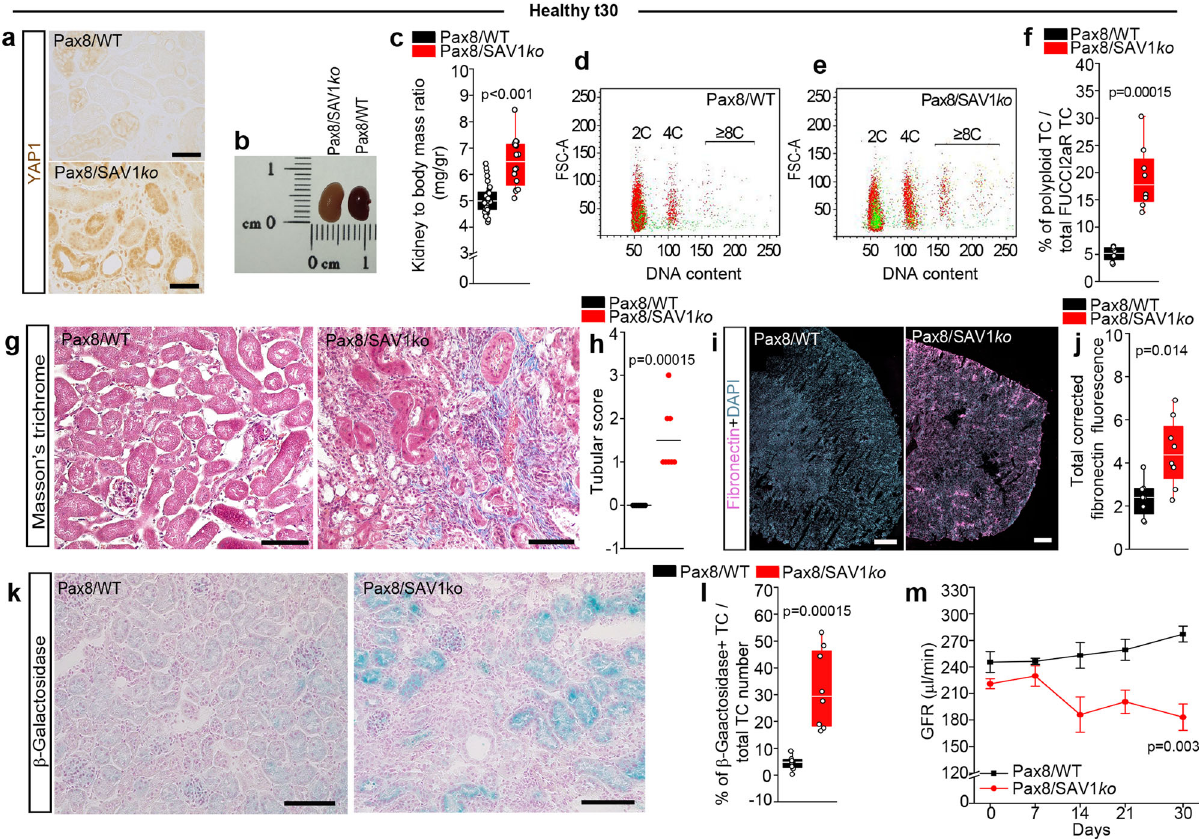
Fig. 6 | Pax8/SAV1 ko healthy mice show increased tubular cell (TC) poly- ploidization and spontaneously progress toward CKD. a Representative pic- tures for immunohistochemistry of active-YAP1 staining. Bars 100 µ m. A representative experiment out of 4 is shown. b Picture of Pax8/FUCCI2aR/SAV1 ko (Pax8/SAV1 ko ) and Pax8/WT kidneys. c Kidney weight in Pax8/WT ( n =30) and Pax8/SAV1 ko mice ( n =16), p =7.2×10 − 6 . FACS plots of TC in d Pax8/WT and in e Pax8/SAV1 ko mice,showingdiploid(2C),tetraploid(4C)andoctaploidorgreater ( ≥ 8C) TC. Colours match the FUCCI2aR reporter ( n =8). f Percentage of polyploid TC ( n =8). g Representative pictures of Masson ’ s trichrome staining ( n =8). Bars 100 µ m. h Tubular score evaluated on Masson ’ s trichrome staining ( n =8).